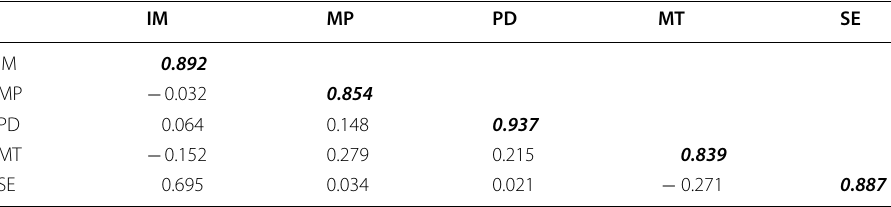
Diagonal values in italics are square roots of AVEs